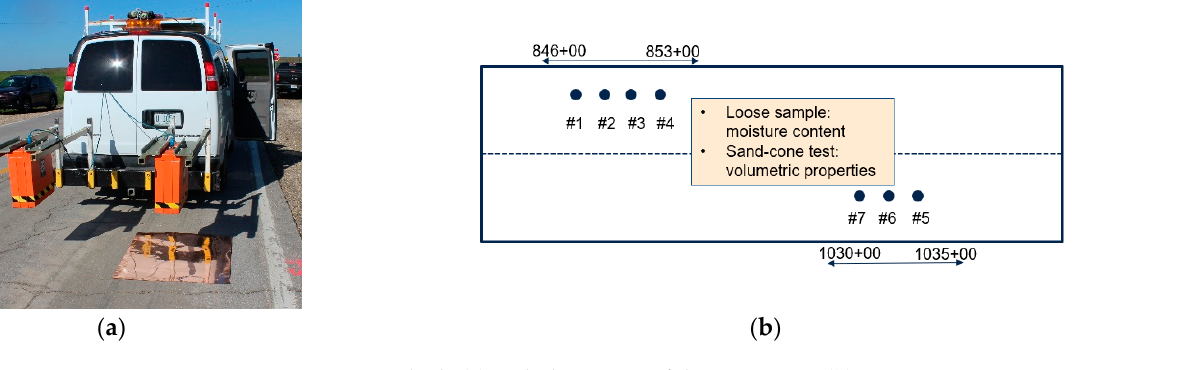
Figure 7. GPR testing vehicle ( a ) and plane view of the testing site ( b ). Table 1. Summary of test information.